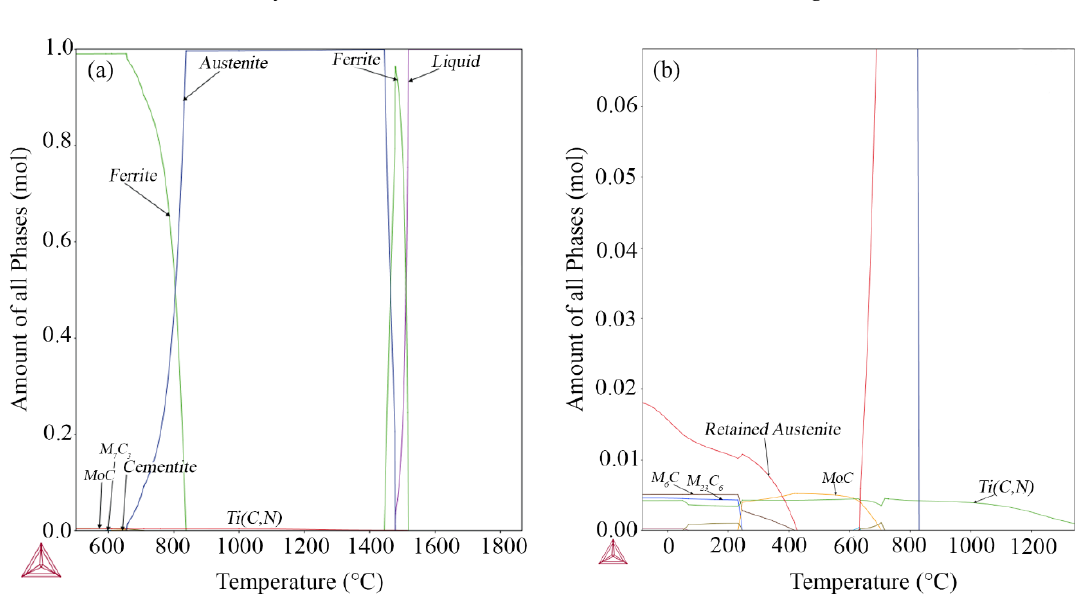
Figure 2. Amount of all phases calculated with Thermocalc: ( a ) full range of phases; ( b ) focus on carbides.